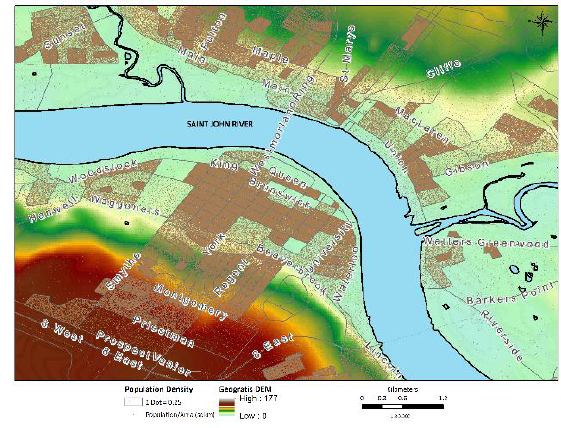
Figure 6. Fredericton, NB. Local topography and population density